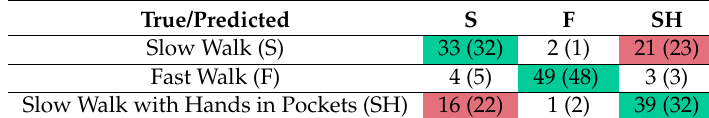
Table 4. Confusion matrix obtained applying SVM and kNN (into parentheses) on three different classes, considering 9 principal components, acc SVM = 72%, acc KNN = 66.7%.